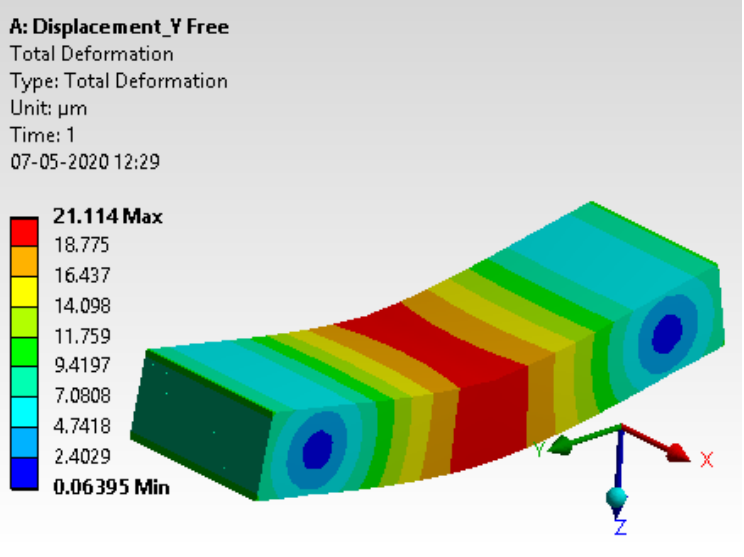
Figure 14. Total